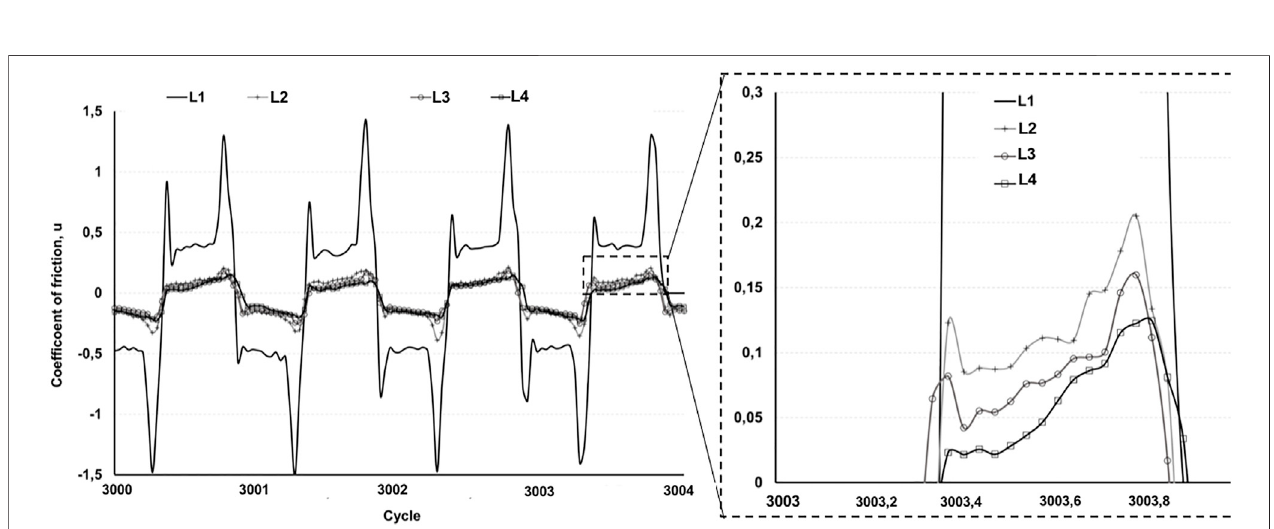
FIGURE 7 | The presence of additive in the lubricant stabilizes the friction of the tribo-pair; CoF at sliding distance 45 m.